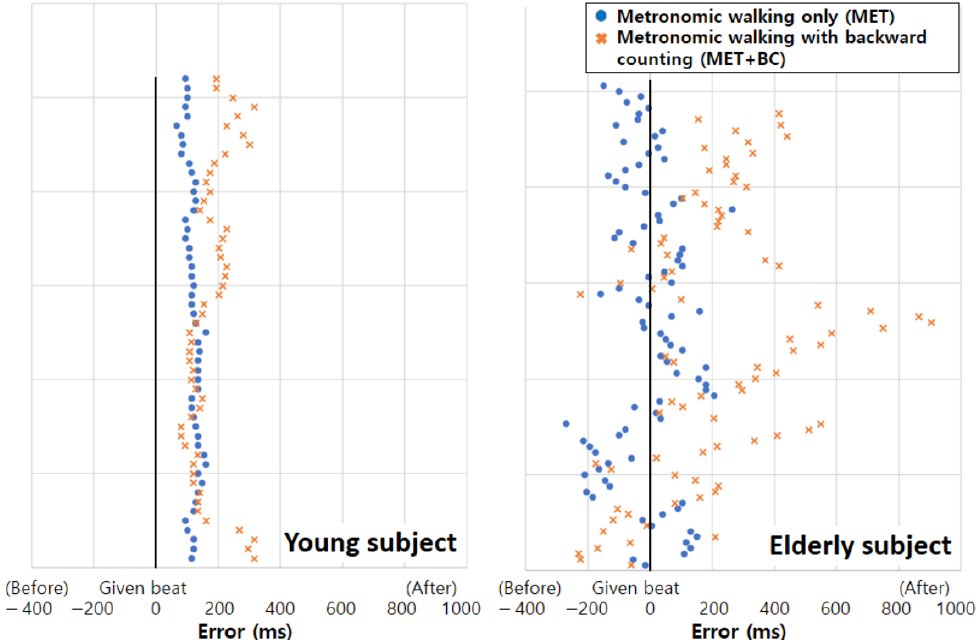
Figure 1. Examples of the temporal errors between the metronome beat and the heel contact for each gait condition by age (Young subject: subject #1, Elderly subject: subject #8).